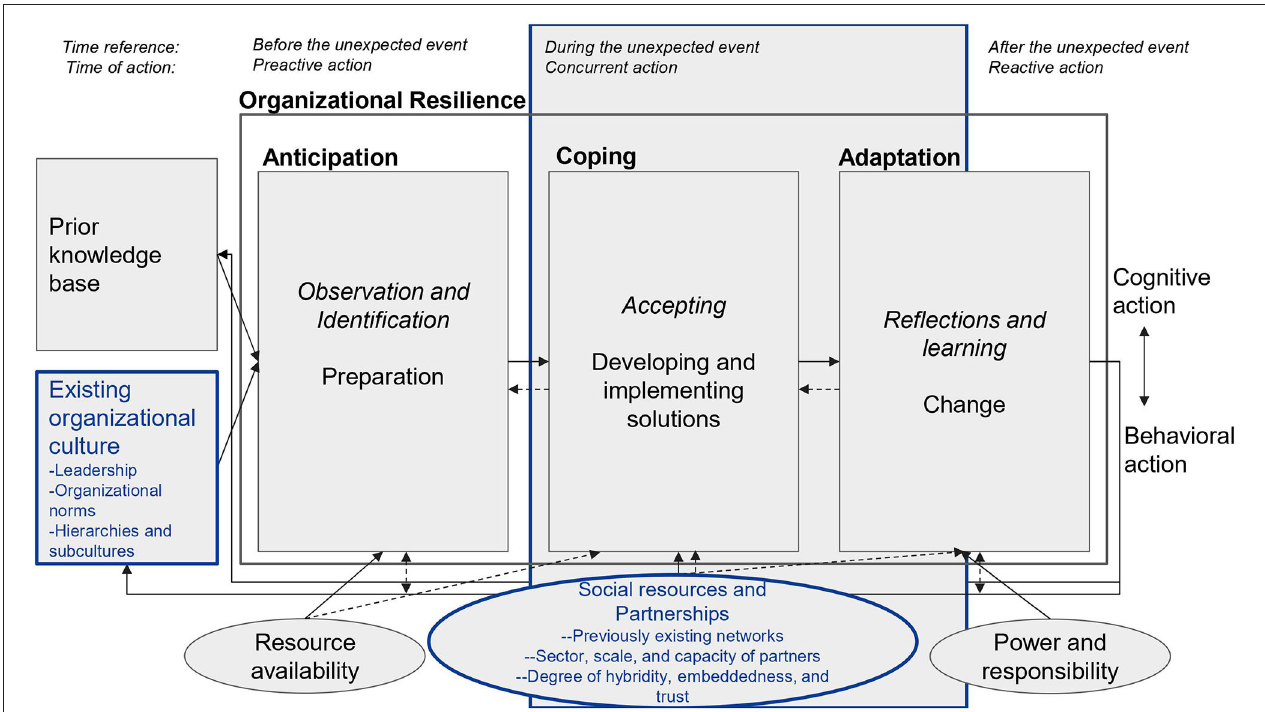
FIGURE 2 | Revised conceptual model of organizational resilience, based on Duchek (2020) under the terms of the Creative Commons 4.0 International License (http://creativecommons.org/licenses/by/4.0/). Bolded boxes indicate additions based on empirical cases of public land organizations during the twinned crises of COVID-19 pandemic and systemic racial